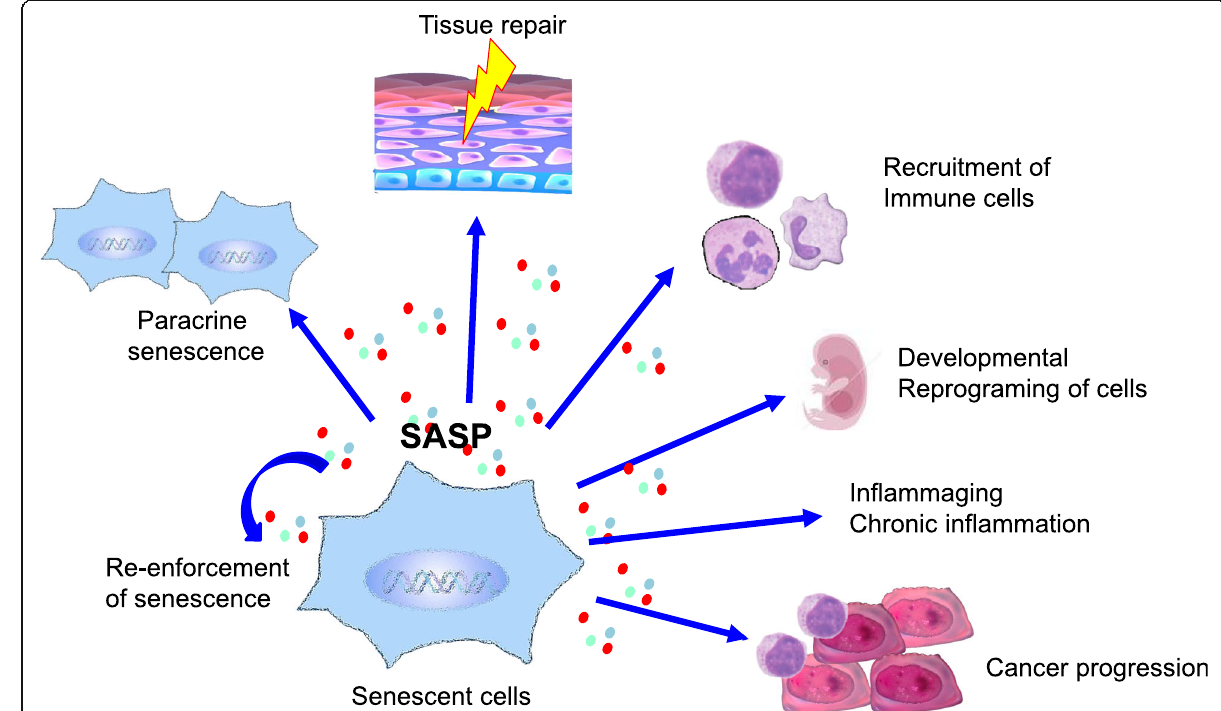
Fig. 1 The effect of SASP factors. SASP factors can re-enforce cellular senescence in a autocrine manner. SASP factors can also act in a paracrine manner, inducing senescence of surrounding cells (paracrine senescence). SASP factors facilitate tissue repair and recruitment of immune cells. SASP factors are involved in development (developmental senescence). On the other hand, SASP factors are associated with chronic inflammation and cancer progression when